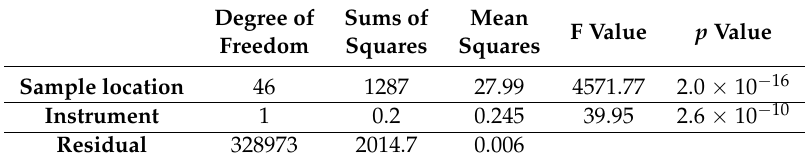
Table 7. 2-Way ANOVA.